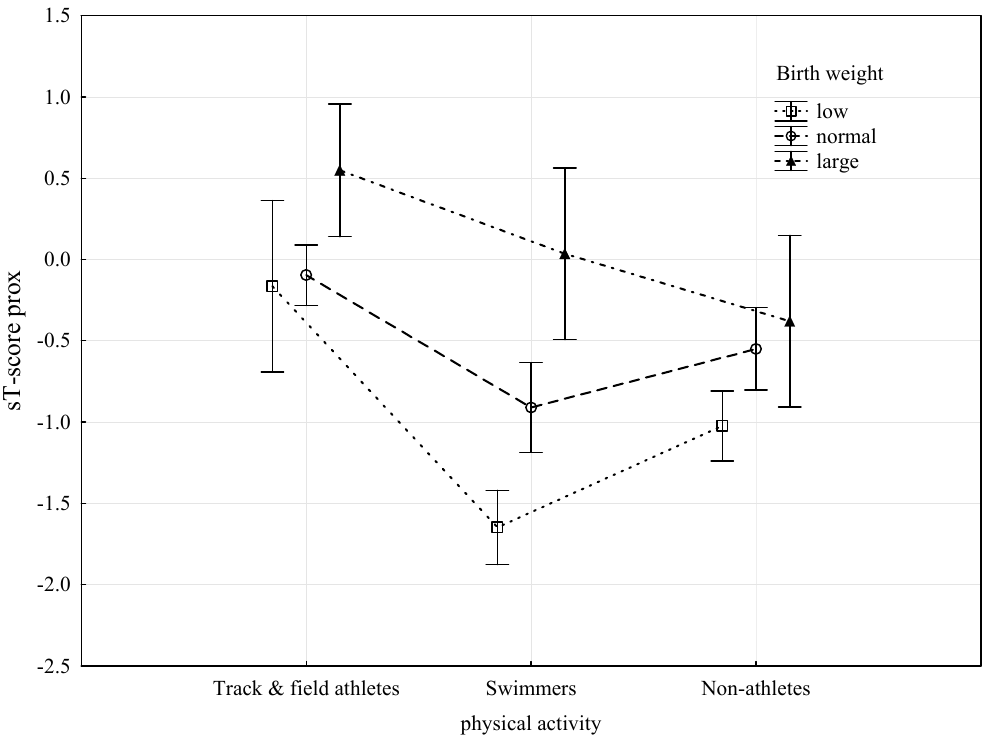
Figure 1. Relationships of PA category and birth weight with sT-score prox (ANOVA results).